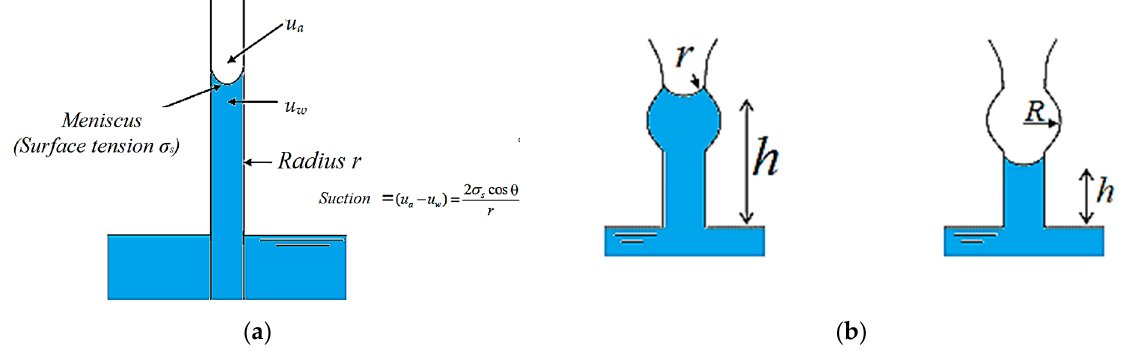
Figure 1. The illustration of soil matric suction: ( a ) capillary pressure and Young–Laplace equation; ( b ) ink-bottle effect leading to imbibition and hysteresis in scanning loops [69].